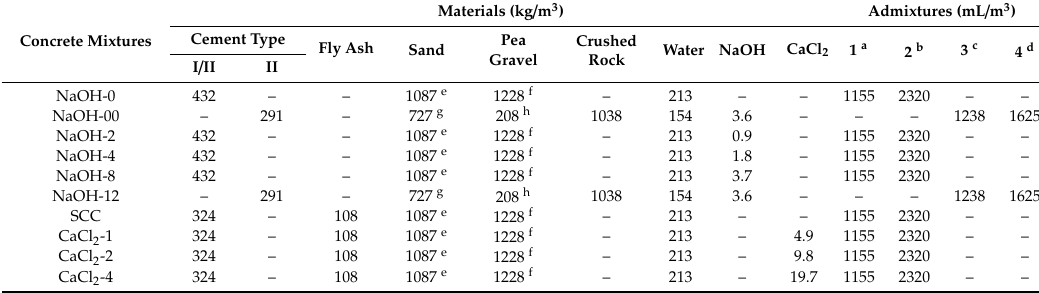
Table 2. Proportions of the concrete